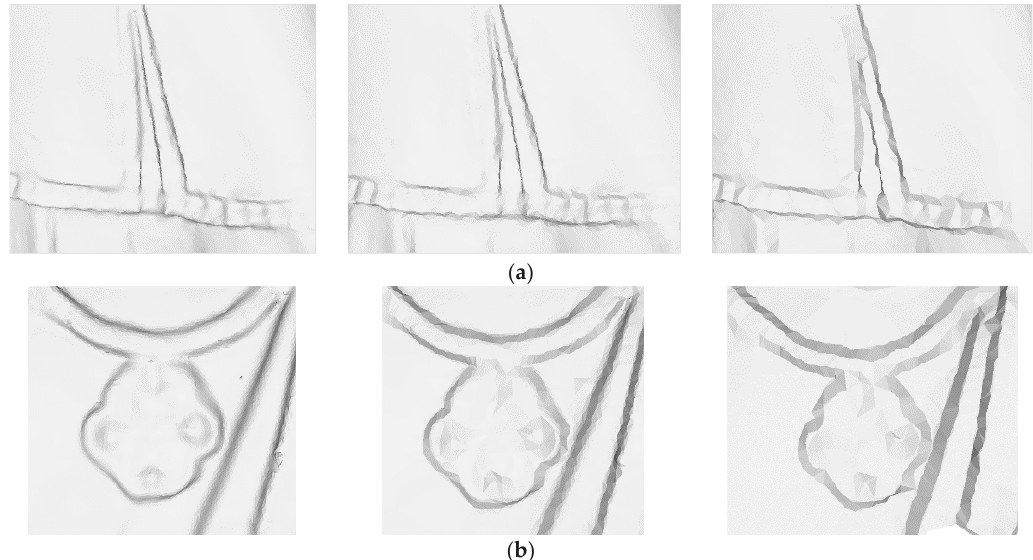
Figure 12. Comparison between 3D meshes at levels δ = 1.0, 2.0, and 3.0. ( a ) Multiple levels of smocking, ( b ) Multiple levels of necklace. ( b ) Multiple levels of